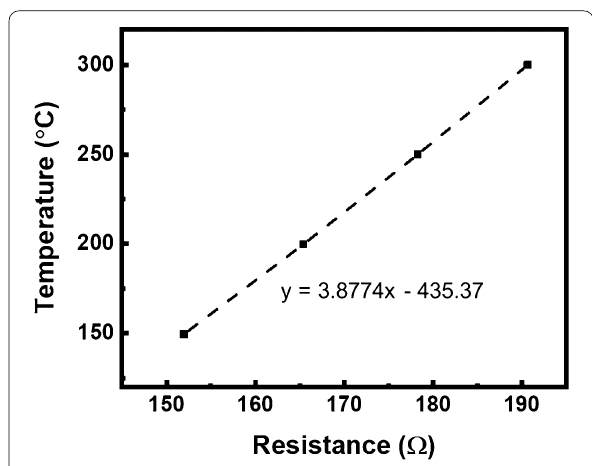
Fig. 2 Resistance characterization of MEMS microheater at various temperature in the furnace system